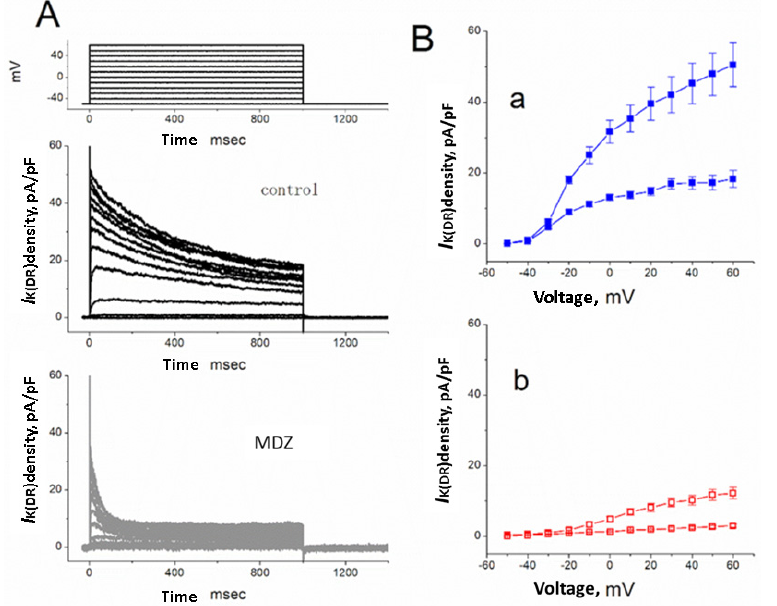
Figure 2. Inhibitory effect of MDZ on I K(DR) density in Jurkat T-lymphocytes. In this set of experi- ments, Jurkat cells were bathed in Ca + -free Tyrode’s solution and the recording pipette was filled with K + -containing solution described under Materials and Methods. ( A ) Superimposed current densities obtained in the absence (upper) and presence (lower) of 30 µ M MDZ. The examined cell was depolarized from − 50 mV to a series of the potentials ranging from − 50 to +60 mV in 10-mV increments. The uppermost part indicates the voltage protocol examined. ( B ) Average current density versus voltage relations for initial (square symbols) and late (circle symbols) components of I K(DR) density in the absence ( Ba ; filled symbols) and presence ( Bb ; open symbols) of 30 µ M MDZ (mean ± SEM, n = 9–12 for each point).